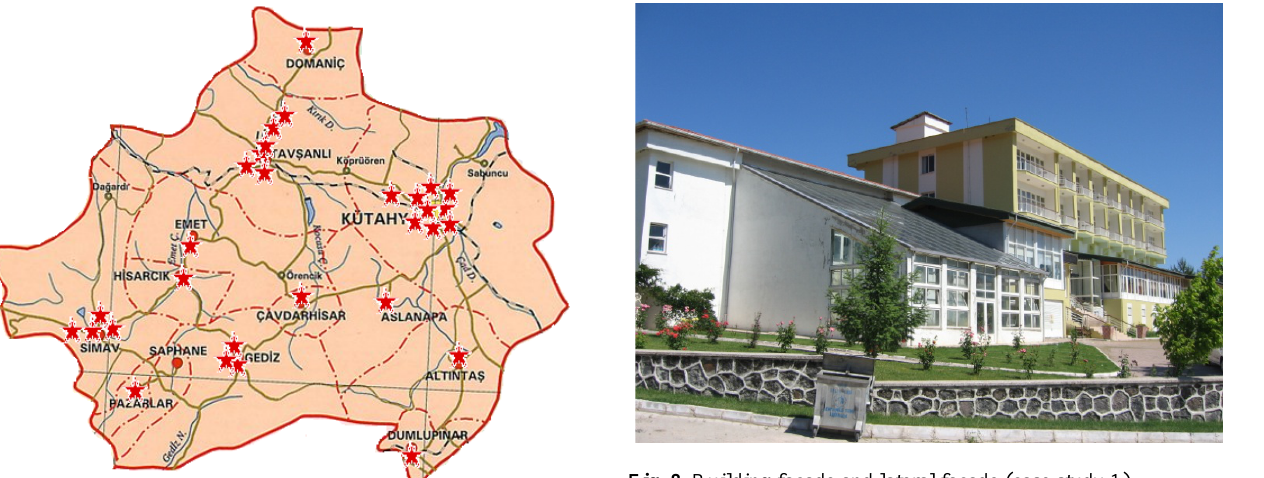
Fig. 8. Building facade and lateral facade (case study